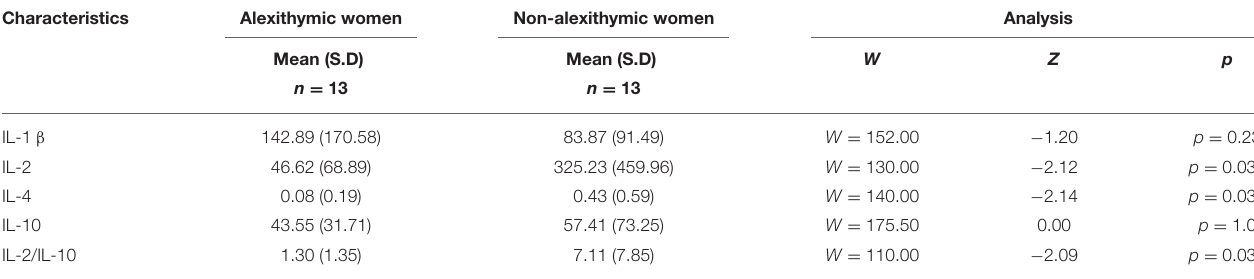
TABLE 3 | Cytokines produced by PHA stimulated lymphocytes (1-year later).